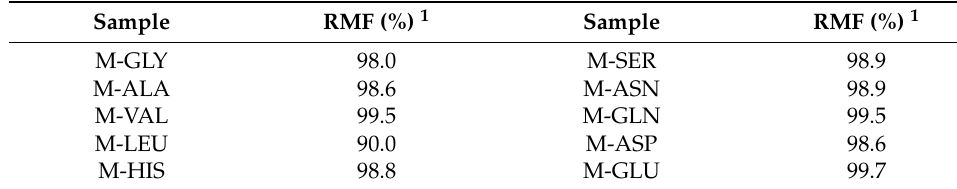
Table 4. PAA ignition test data.